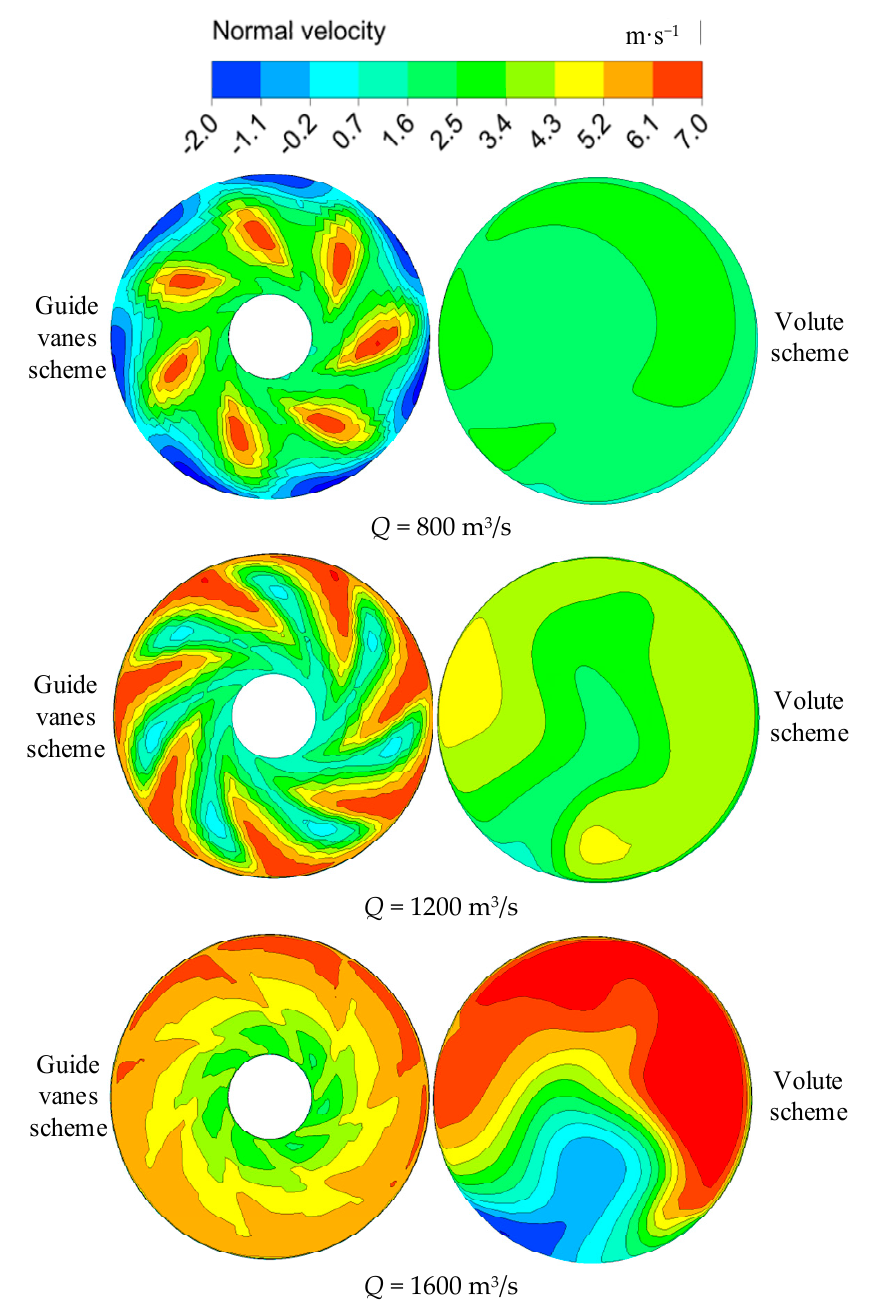
Figure 16. Distribution of normal velocity on the inlet of the outlet pipe at different flow rates.